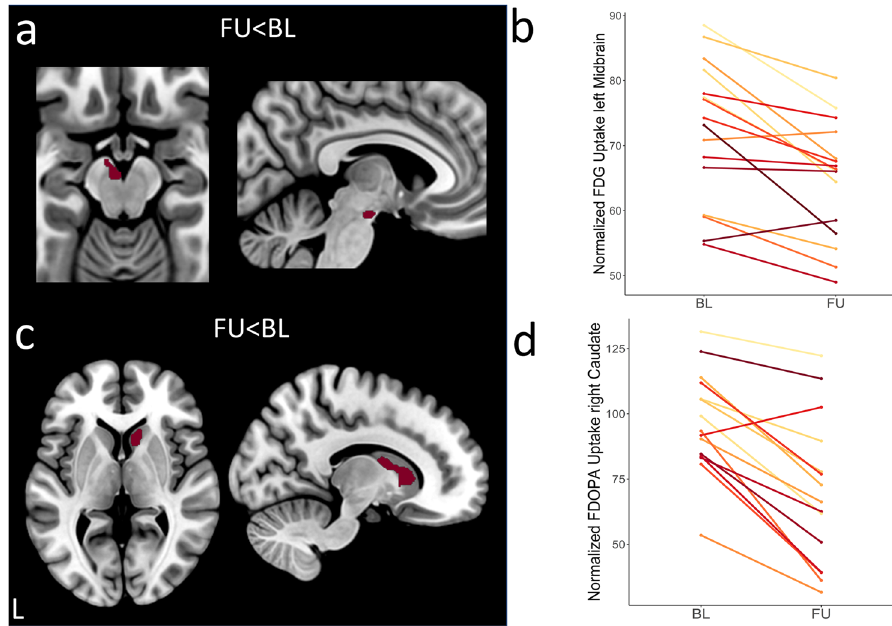
Fig. 2 Direct comparison of FDG and FDOPA uptake between follow-up and baseline. Patients showed signi fi cantly reduced FDG uptake in the left midbrain ( a ) and signi fi cantly reduced FDOPA uptake in the right caudate ( c ) at follow-up visits compared to baseline. Both clusters are displayed in binarized form. Results were obtained by applying the above stated contrasts, thresholded at p FWE < 0.05 cluster-level corrected with SVC for midbrain ( a ) or striatum ( c ), respectively. Progression plots show the decrement of tracer uptakes between both visits for each patient individually for left midbrain FDG uptake ( b ) and right caudate FDOPA uptake ( d ). Progression plots contain extracted normalized FDG and FDOPA values with proportional scaling. BL = baseline, FU = follow up, HC = healthy